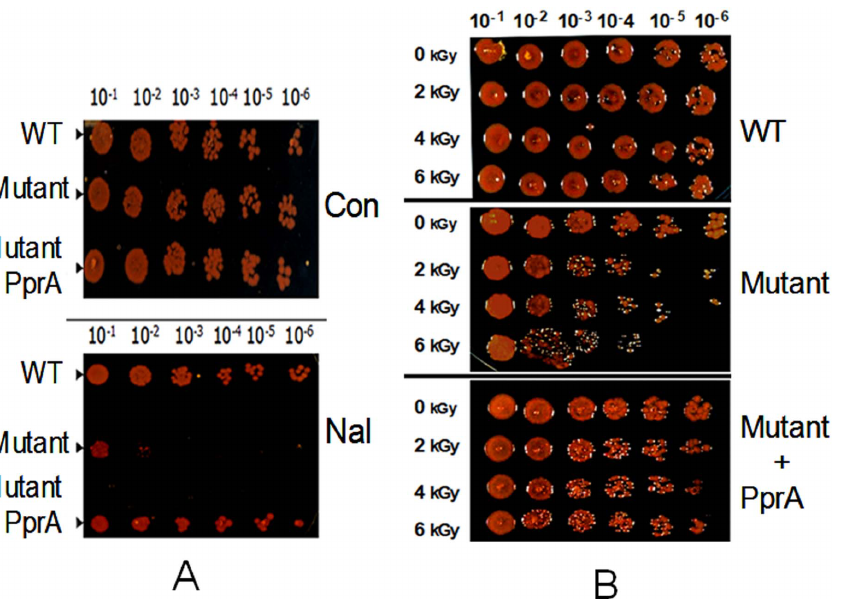
nalidixic acid (Nal) (20 m g/ml) (A). Similarly, these cells were treated with different doses of c radiation and different dilutions were spotted on TGY agar plate and growth was monitored (B).